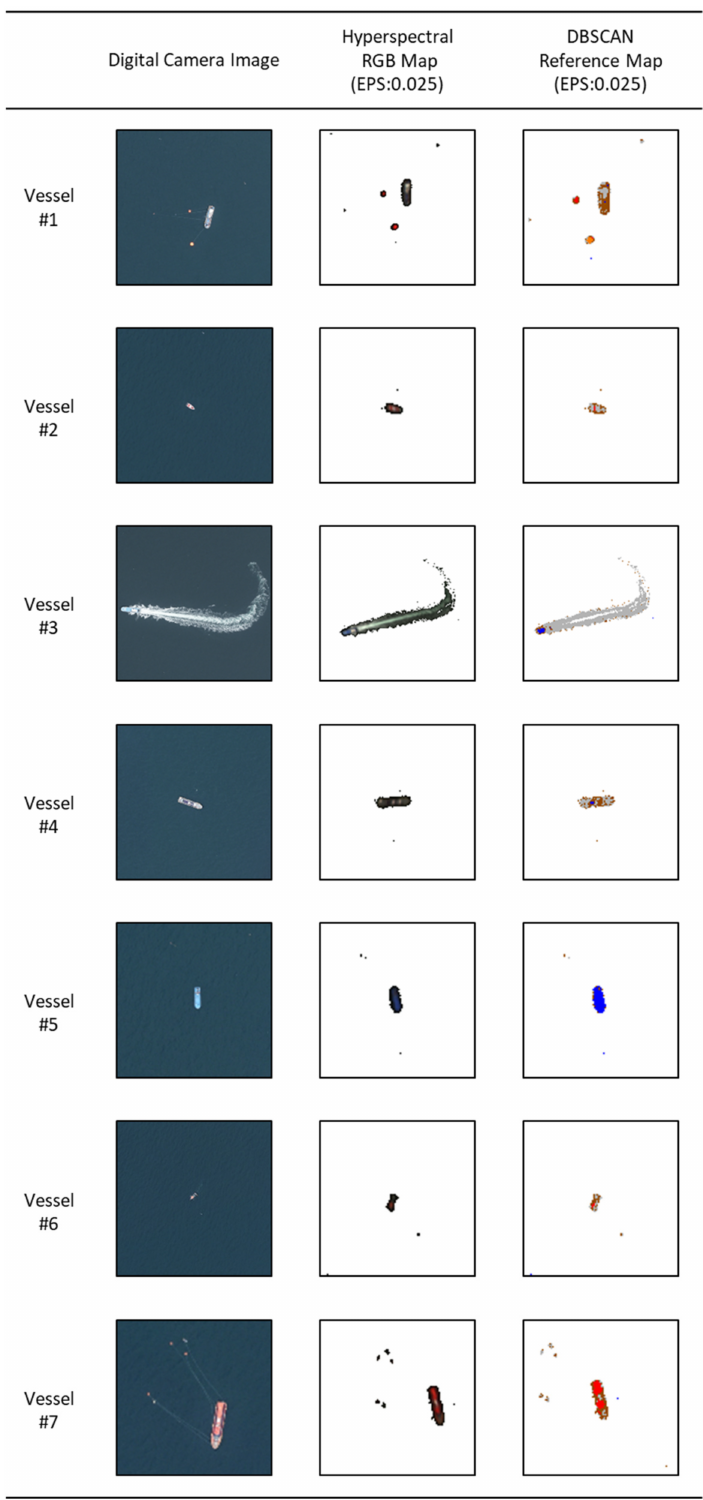
Figure 8. Coloring method of the detected pixels using cosine similarity. The pixels of the maritime object detected by DBSCAN are compared with the reference spectrum and replaced with color in high similarity (DBSCAN Reference map). Ultra-high-resolution DMC images and hyperspectral RGB map images that applied hyperspectral RGB color mapping to the DBSCAN detection results were added to facilitate intuitive viewing and checking of the color mapping results for each of the